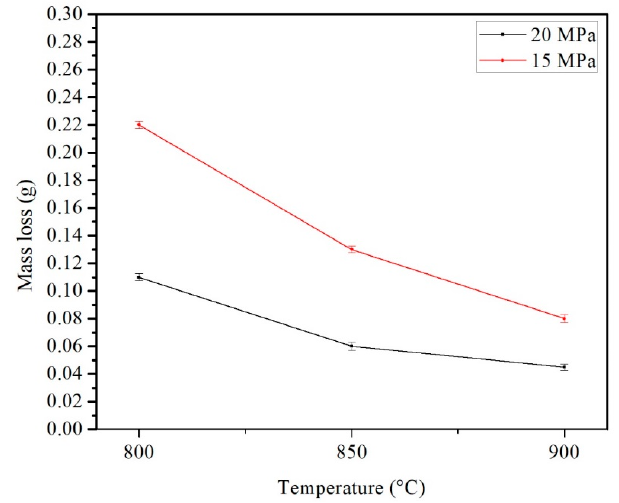
Figure 12. Average mass loss including scattering bars of the coated stainless steel AISI 304L ( α -Al 9 FeMnSi coating) as a function of processing pressure and temperature after pin-on-disk wear testing.